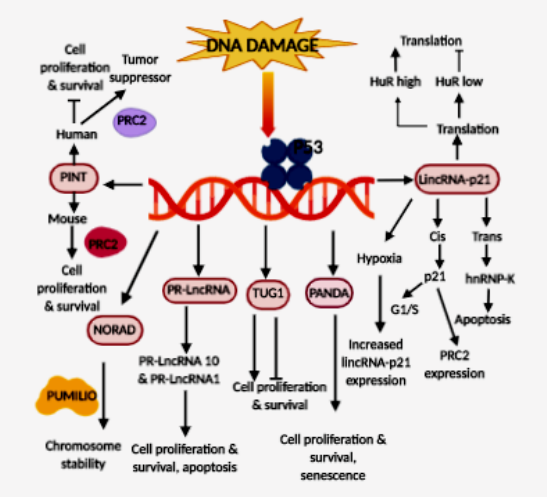
Figure 1. The role of p53-effectors of lncRNAs that are regulated by p53; LincRNA-p21 functions in both cis and trans. In cis, it regulates the expression of its neighboring gene p21 and in trans, it interacts with RNA binding protein hnRNP-K to exert its proapoptotic role. The lincRNA-p21 expression is induced during hypoxia. LincRNA-p21 regulates translation in the cytoplasm; PANDA has a pro-survival function as it promotes cell survival and inhibits apoptosis; Human PINT interacts with PRC2 and acts as a tumor-suppressor, whereas mouse ortholog increases cell survival and proliferation; PR-lncRNA1 and PR-lncRNA10 have proapoptotic function and they inhibit cell survival and proliferation; TUG1 promote or inhibit cell proliferation and cell cycle progression depending on the tumor type; NORAD interacts with PUMILIO proteins to maintain genomic